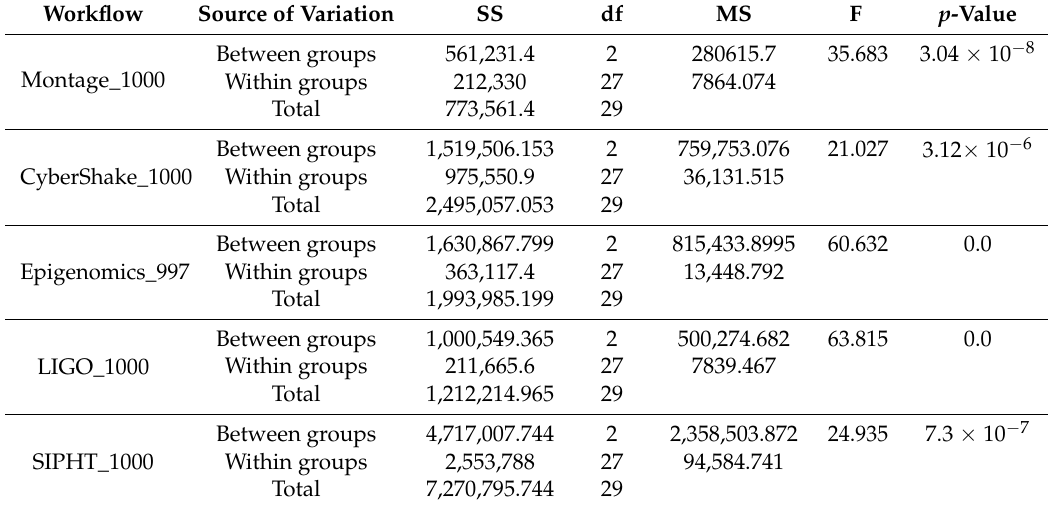
Table 4. One-way ANOVA test